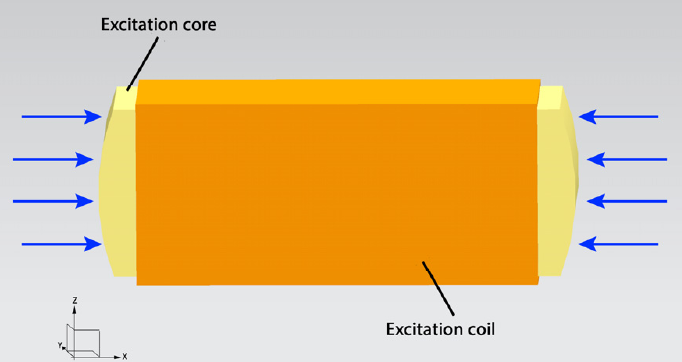
Figure 2. Magnetic force model of iron-cobalt alloy prism.